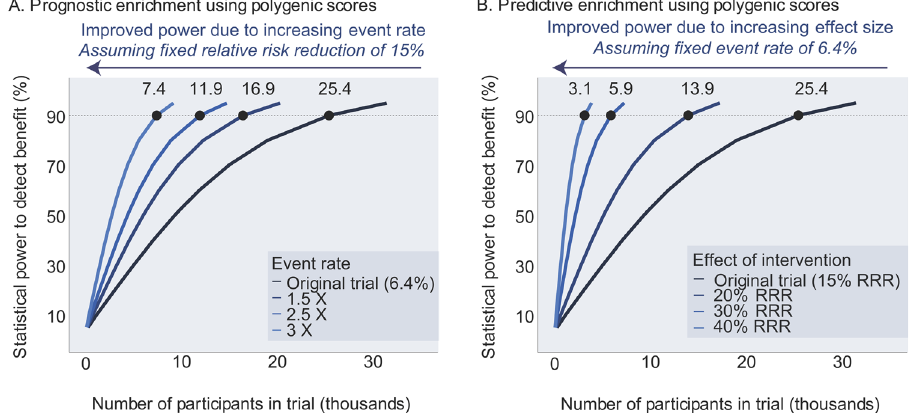
Fig. 1 Power and sample size estimation using prognostic or predictive model for polygenic score enrichment. The FOURIER clinical trial randomized 27,564 patients with cardiovascular disease to a placebo or evolucumab, a cholesterol-lowering therapy, and followed patients for a median of 2.2 years 4 . This trial design was based on a power calculation that predicted an event rate of ~6.4% in the control arm and a relative risk reduction (RRR) of 15% 28 . We used these data to model power calculations using polygenic score enrichment under either of two models. A With prognostic enrichment (increasing event rates beyond the 6.4% in the original trial), a polygenic score enrichment improves statistical power to detect a bene fi t despite a fi xed effect size (relative risk reduction of 15%); B with predictive enrichment (increasing effect size of intervention beyond the 15% RRR in the original trial), a polygenic score enrichment improves power with a fi xed event rate in the placebo arm of 6.4%. The dashed line in both panels denotes 90% power to detect a statistical bene fi t, a threshold commonly used in trial design. Using polygenic scores to enrich clinical trials could markedly improve power and reduce the number of participants needed by increasing event rates ( “ prognostic enrichment ” ) and/or increasing the effect size ( “ predictive enrichment ”